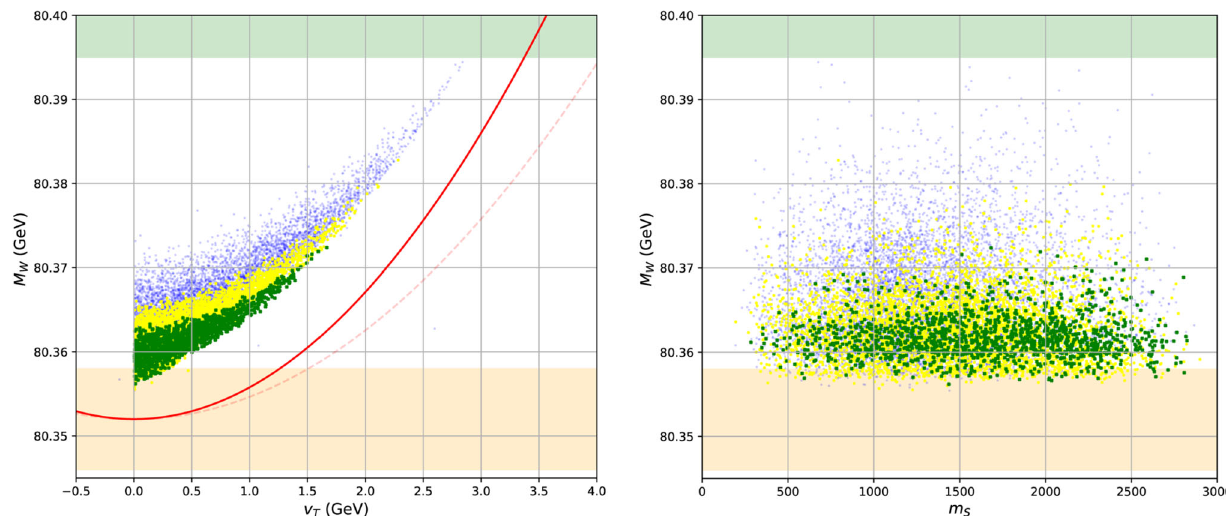
Fig. 4 W boson mass in the aligned DGNMSSM. Left: W boson mass against triplet expectation value. Right: W boson mass against singlet-like Higgs mass. Colour coding of points is described in the text